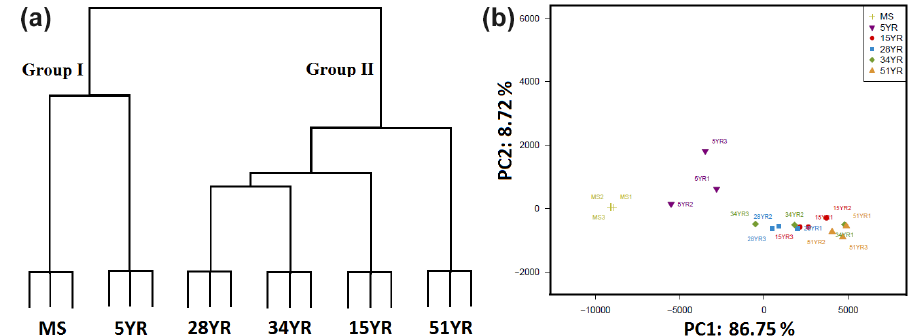
Figure 3. Hierarchical clustering analysis and PCA of bacterial communities in six different ages of BSCs at OTU level based on 97% similarity (triplicate samples for each age). MS, 5YR, 15YR, 28YR, 34YR and 51YR represent mobile sand, 5-, 15-, 28-, 34- and 51-year- old BSCs,